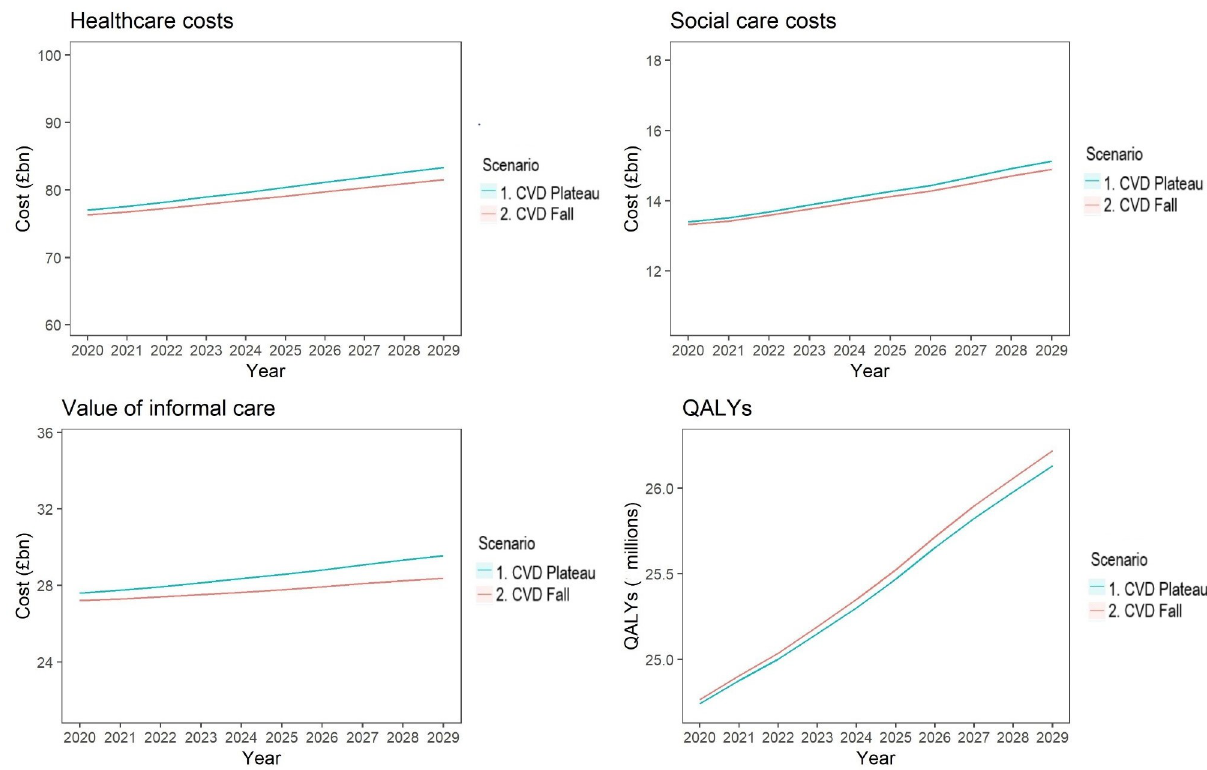
Fig 2. Modelled healthcare costs, social care costs, value of informal care, and QALYs, from 2020–2029, comparing Scenario 2 (Continuing decline in CVD incidence) with Scenario 1 (plateaued CVD incidence). Healthcare costs are total NHS costs based on ELSA data linked with NHS England HES data. Social care costs are based on ELSA and include cleaner, care/nursing home staff, other formal help, Local Authority-provided home care worker/ home help, and non-Local Authority home care worker/ home help, as well as residential care. Informal care costs are based ELSA data multiplied by ONS estimates of gross value added per hour of care. QALYs are quality adjusted life years experienced per year, across the whole population, aged 35–100.